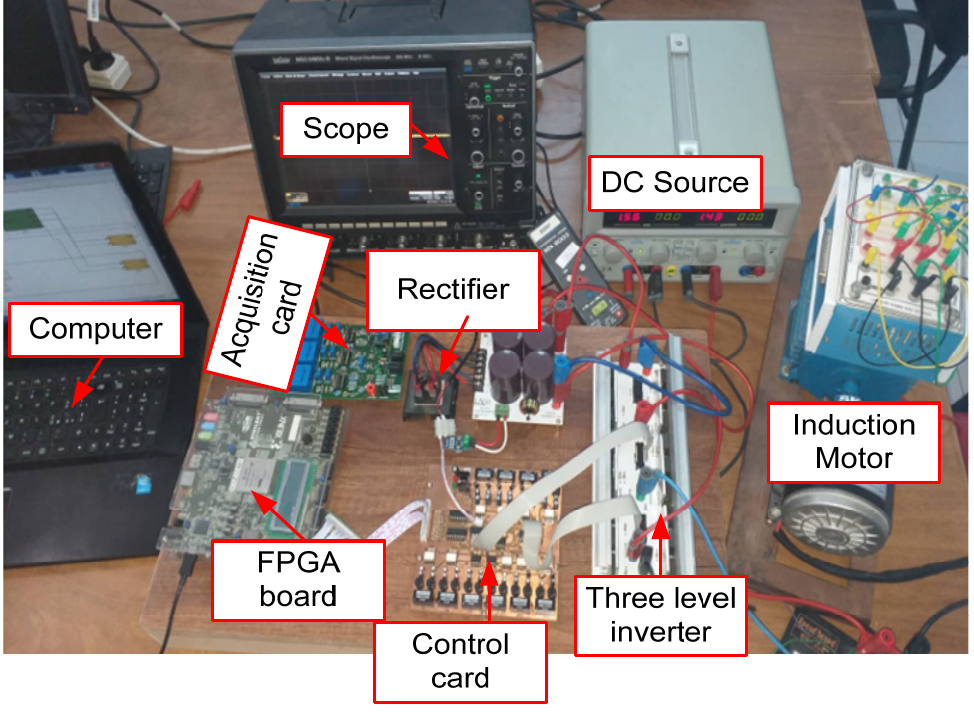
Figure 16. Experimental test